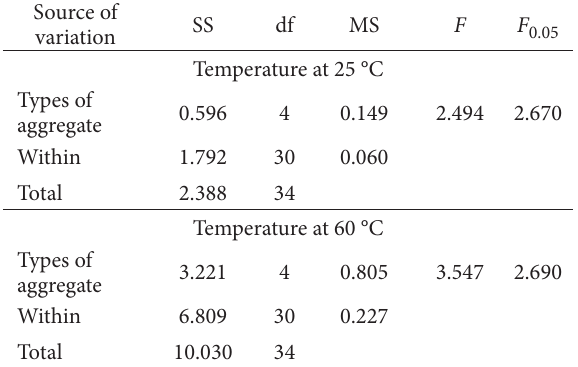
Table 5. One way ANOVA test on permanent deformation